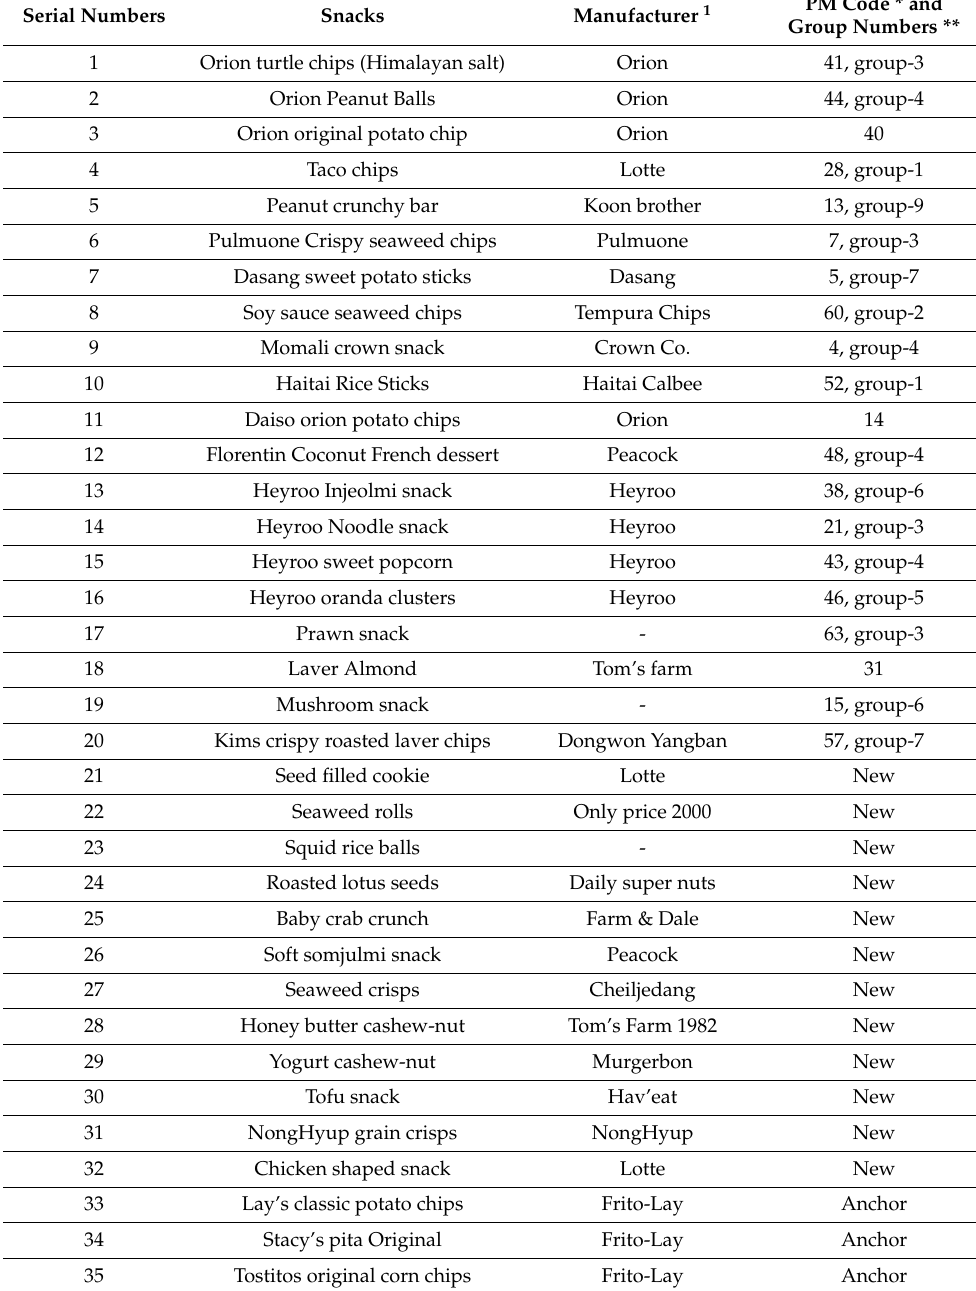
Table 2. List of South Korea (SK) snacks screened for descriptive